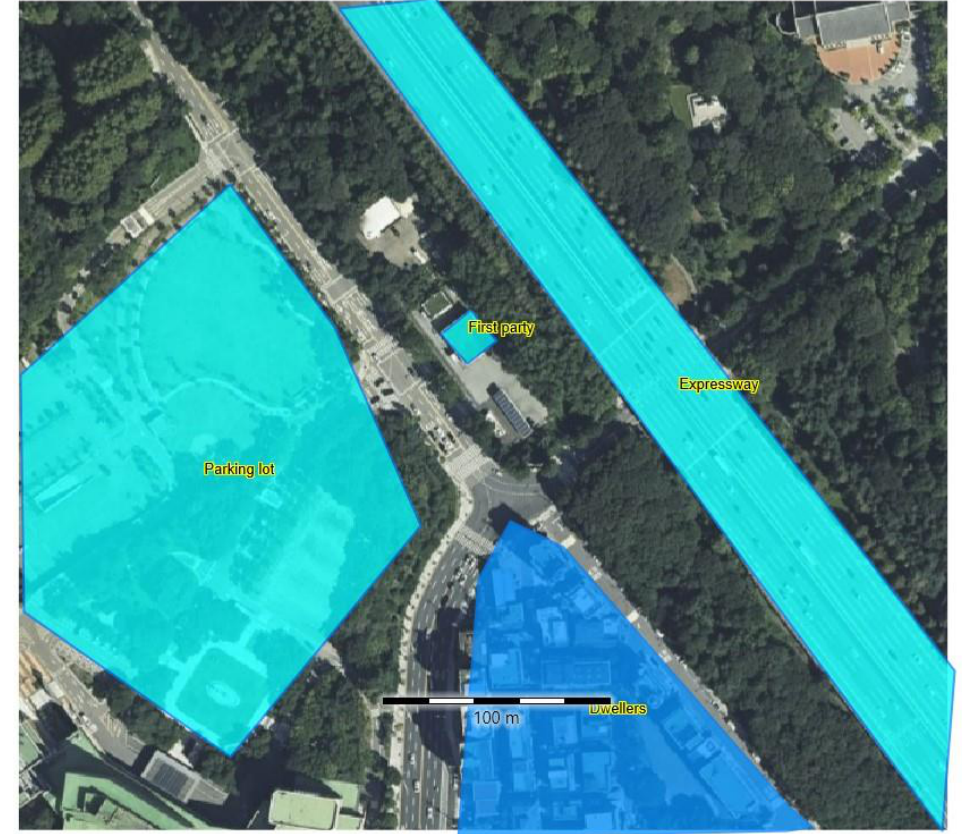
Figure 3. Satellite image of the HRS considered in this study. An expressway exists east of the HRS, and a residential area exists to the south of the HRS. and a residential area exists to the south of the